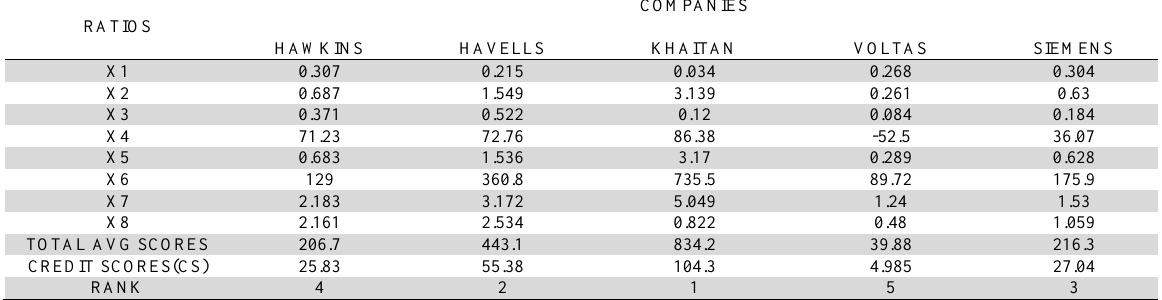
Ranking on the basis of Credit Scores of the Selected Companies of Consumer Durable Sector RATIOS